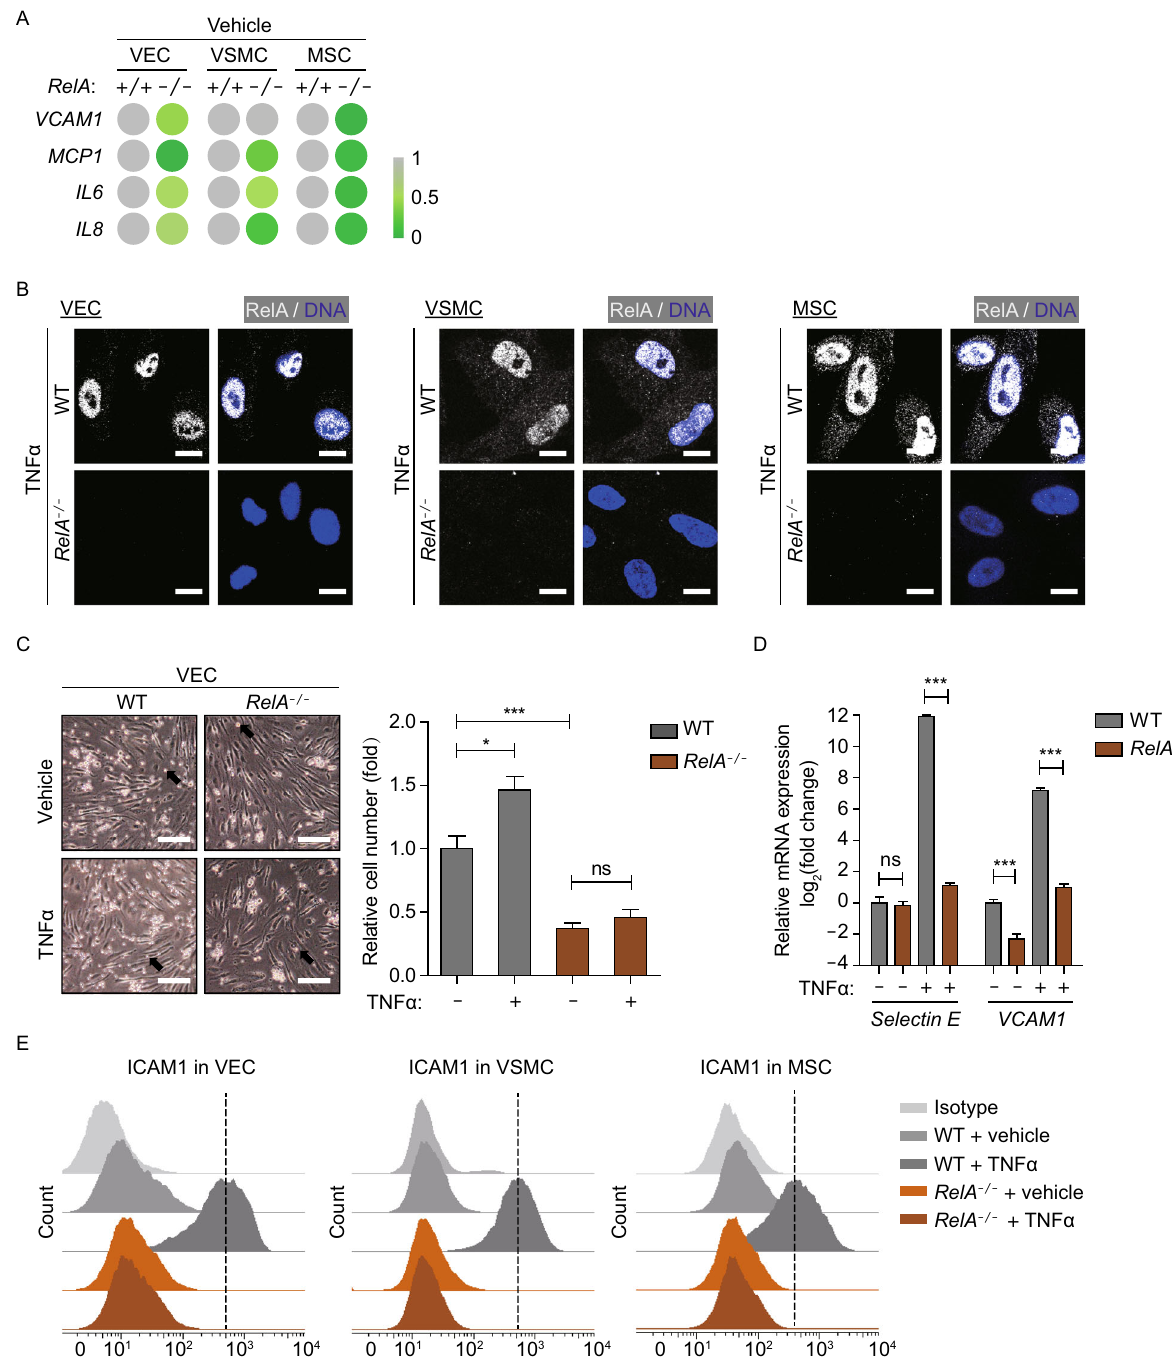
Figure 4. In fl ammatory response defect in RelA − / − vascular cells. (A) Transcriptional expression of NF- κ B target genes in WT and RelA − / − VECs, VSMCs, and MSCs under basal condition via RT-qPCR detection ( n = 4). (B) Immunostaining of RelA in WTand RelA − / − VECs, VSMCs and MSCs upon 10 ng/mL TNF α treatment. Scale bar, 10 μ m. (C) Monocyte adhesion on WT and RelA − / − endothelium under basal and 10 ng/mL TNF α -induced in fl ammatory conditions ( n = 3). Black arrows indicate monocytes. Random fi elds were selected and the numbers of monocytes were counted by ImageJ software. ns, not signi fi cant; * P < 0.05; *** P < 0.001. (D) Transcriptional expression of adhesion molecules in WT and RelA − / − VECs under basal and 10 ng/mL TNF α -induced in fl ammatory conditions via RT-qPCR detection ( n = 4). ns, not signi fi cant. *** P < 0.001. (E) Flow cytometric analysis of ICAM1 in WT and RelA − / − VECs, VSMCs and MSCs under basal and 10 ng/mL TNF α -induced in fl ammatory conditions. The black dotted line represents the mean ICAM1 protein level upon TNF α treatment. IgG-PE was used as an isotype